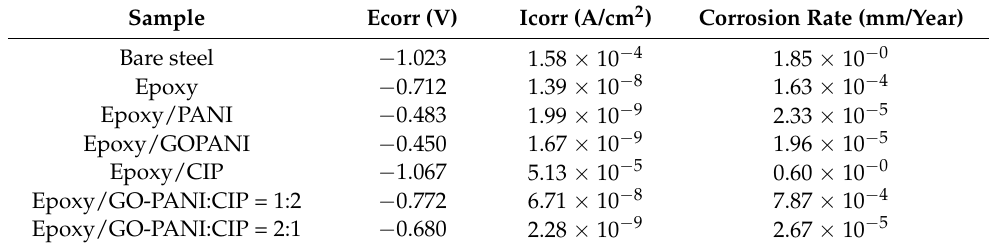
Table 1. The Tafel plot data for the different coatings.